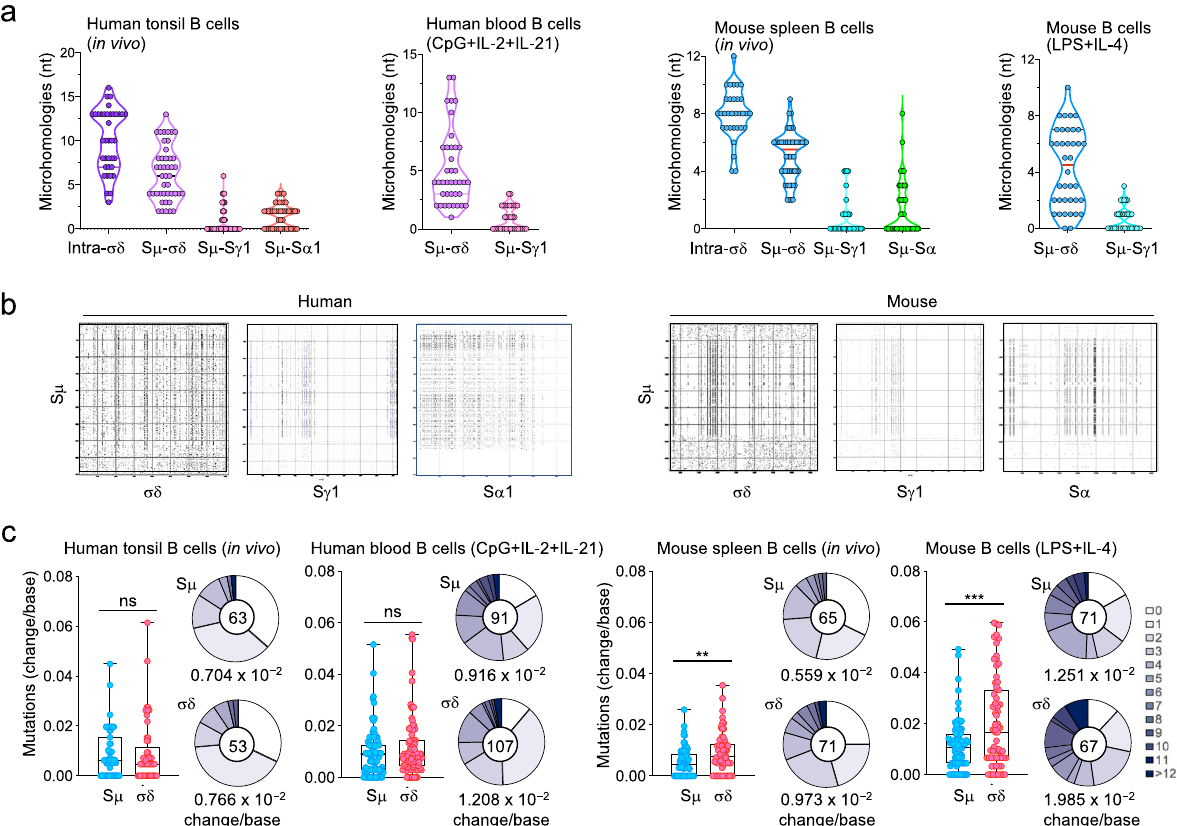
Fig. 3 Mouse and human S μ – σδ DNA recombination junctions contain microhomologies and somatic mutations. a Ampli fi ed DNAs from junctional intra- σδ deletions as well as S μ – σδ , S μ – S γ 1 and S μ – S α 1 recombinations from human tonsil B cells or human peripheral blood naïve IgM + IgD + B cells stimulated with CpG plus IL-2 and IL-21 and cultured for 120 h, OVA-immunized C57BL/6 mouse spleen B cells or C57BL/6 mouse naïve IgM + IgD + B cells stimulated with LPS plus IL-4 and cultured for 96h were ampli fi ed and sequenced by MiSeq. The length and numbers of nucleotide overlaps (microhomologies) in intra- σδ deletions, S μ – σδ , S μ – S γ 1, and S μ – S α 1 junctional DNAs are shown by violin plots. Each dot represents a unique junctional sequence ( n = 45 per group). b Human and mouse S μ and σδ regions consist of repetitive motifs, which are better-suited substrates for Rad52-mediated MMEJ than those in S μ and S γ 1 or S μ and S α . As such, they can facilitate the formation of microhomologies. Repetitive sequence elements in mouse and human S μ , σδ , S γ 1 and S α that can potentially form microhomologies were identi fi ed by Pustell Matrix dot plot using MacVector software and are depicted by small dots. Intensity of dots depicts frequency and degree of complementarity of respective sequences. c Somatic point-mutations in S μ and σδ regions abetting recombined S μ − σδ DNA junctions in IgD class-switched human and mouse B cells in vivo and in vitro. Mutations were identi fi ed in a 48 – 506 nt stretch of S μ or σδ regions in unique S μ – σδ DNA recombination sequences. Each dot represents an individual sequence. Sequence data were pooled from three individuals in each group. Box and whiskers plots show median, quartiles, maximum and minimum of mutation frequencies in S μ and σδ regions. In pie charts, the size of slices denotes the proportion of transcripts with the same number of mutations and the gray hue denotes the number of point mutations per transcript. Center of pie shows the total number of independent sequences analyzed. Below the pie charts is the overall mutation frequency (change/base). ** p <0.01, *** p <0.001, ns: not signi fi cant (unpaired two-tailed t- test). Source data are provided as a Source Data fi